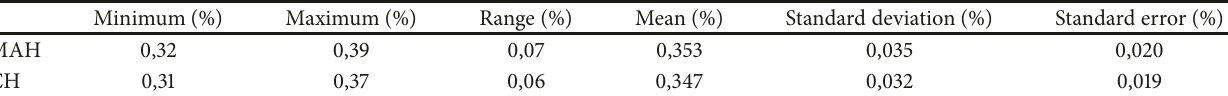
Table 1: Mean value, maximum, minimum, range, Standard error, and Standard deviation of essential oil yield of rosemary.